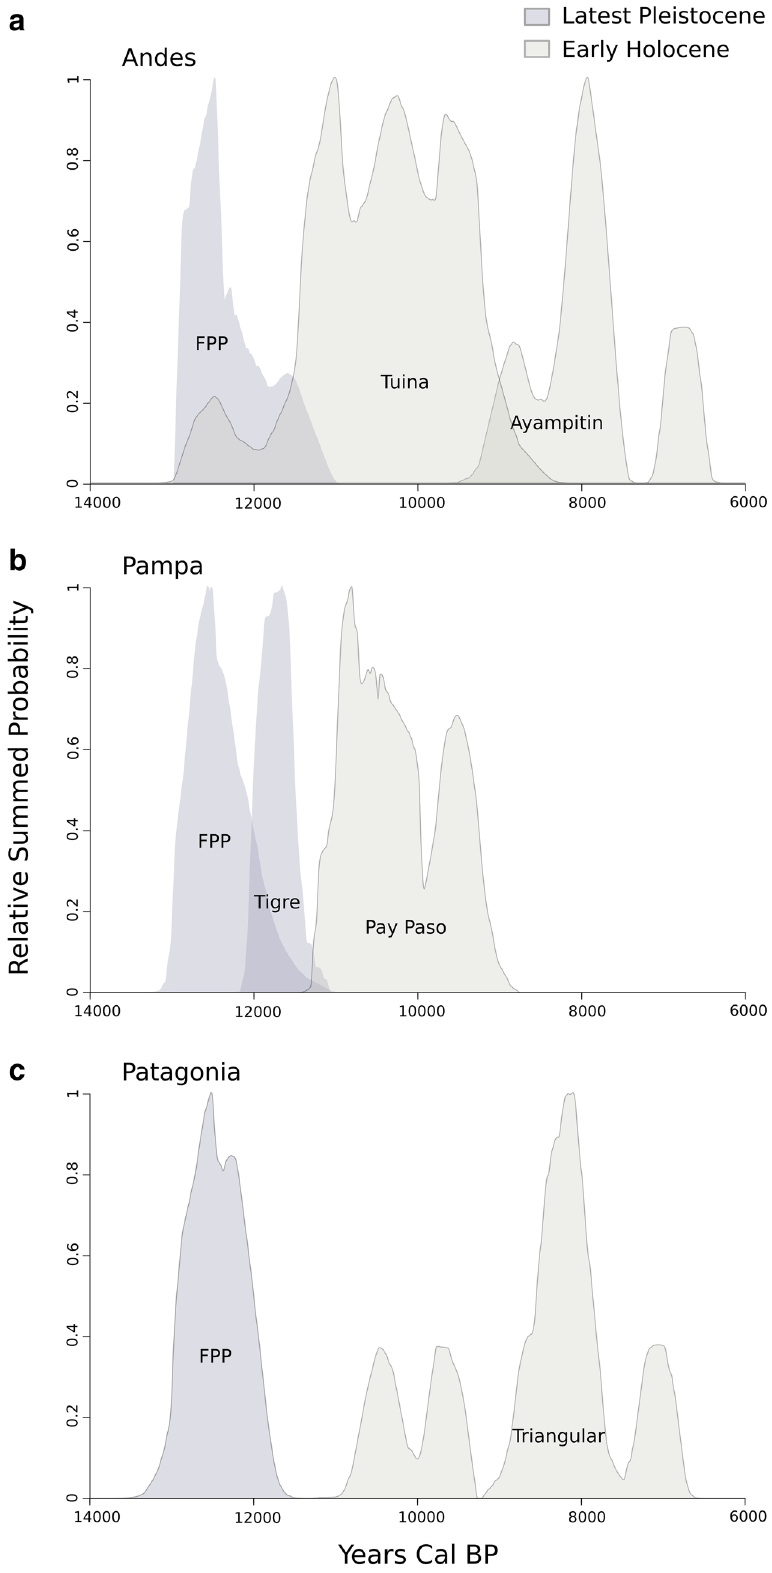
Figure 2. Summed probability distribution curves for three regions in southern South America. The temporal changes are displayed for Andes ( a ), Pampa ( b ), and Patagonia ( c ), using the estimated SCPD curve of each projectile point type or style. We only include projectile point types dated as older than 8.5 k years Cal